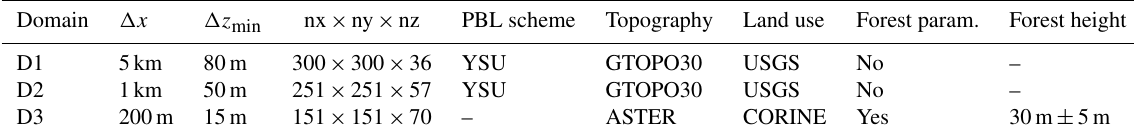
Table 1. Overview of the WRF model set-up. Variables indicate the horizontal resolution ( (cid:49)x ) and the minimum distance of levels in the vertical near the surface ( (cid:49)z min ). The number of grid points in x , y and z directions is marked with nx , ny and nz, respectively.